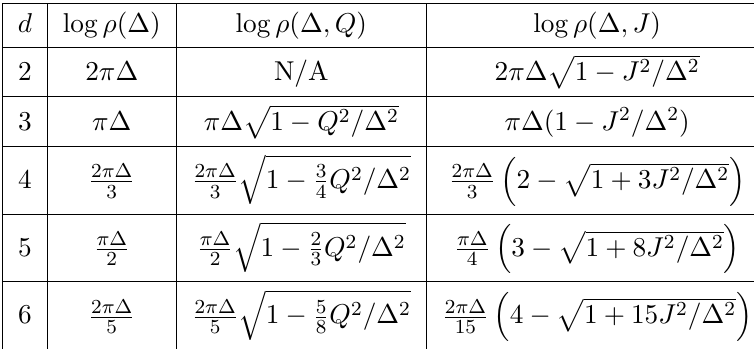
Table 1. Bounds on the density of states for charged spinless operators (second column) and uncharged spinning operators (third column). When these expressions become complex or negative, the bound instead is log (cid:26) =